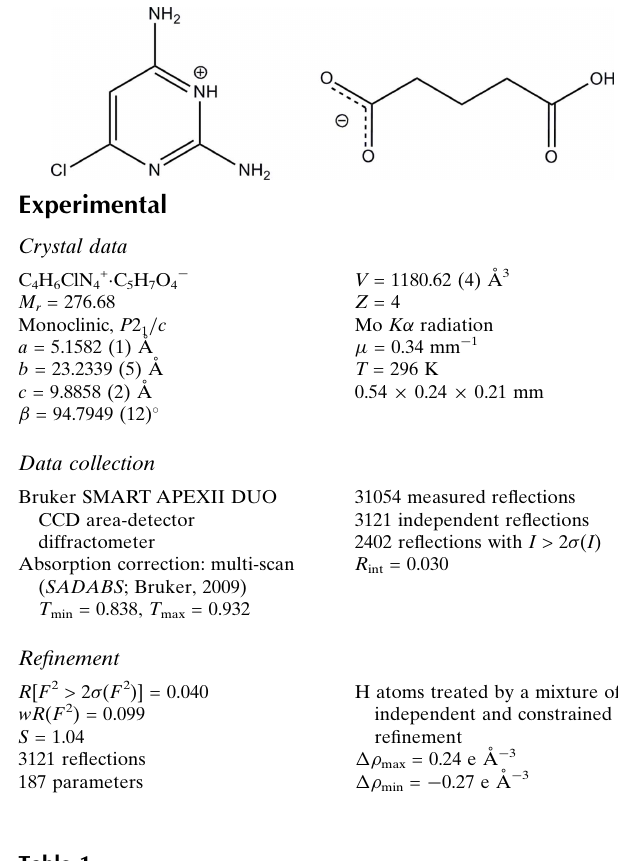
Hydrogen-bond geometry (A˚ , (cid:4) ). D —H (cid:2)(cid:2)(cid:2)